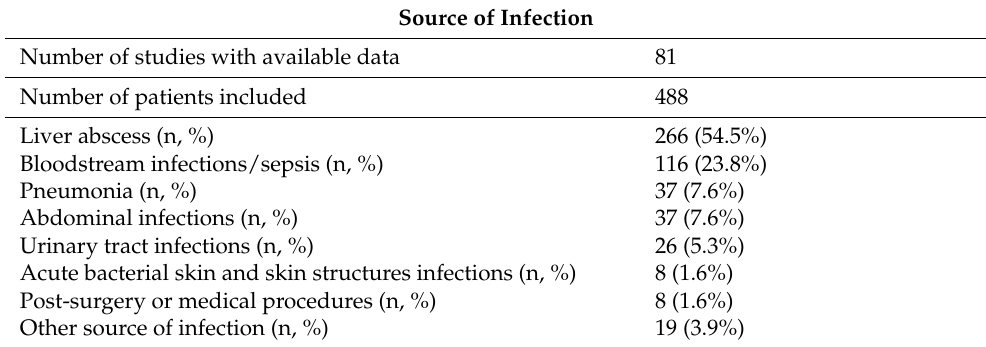
Table 3. Source of infection.